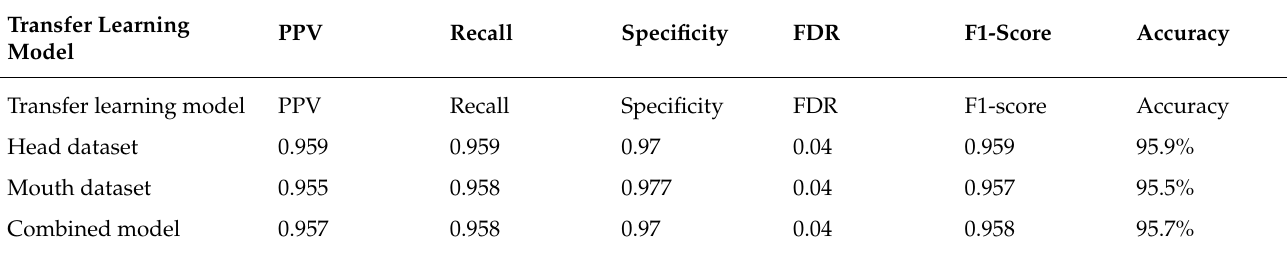
Figure 9. Confusion matrix of the transfer learning model for ( A ) head position dataset and ( B ) mouth movement dataset. Table 7. Performance metrics of the transfer learning